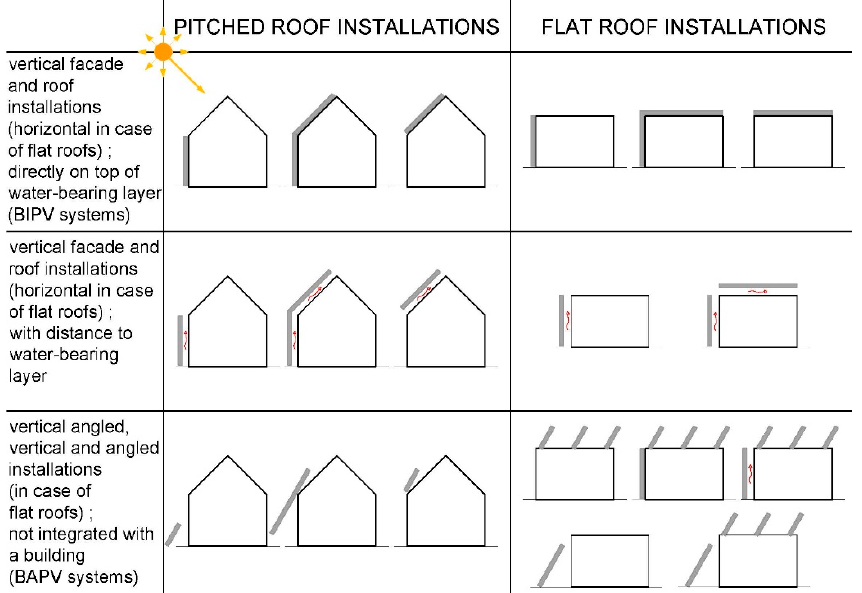
Figure 10. Types of relations between the photovoltaic solar systems and building forms and Figure10. Typesofrelationsbetweenthephotovoltaicsolarsystemsandbuildingformsandcomponents components (diagram by W. Celadyn, P. Filipek). (diagram by W. Celadyn, P.